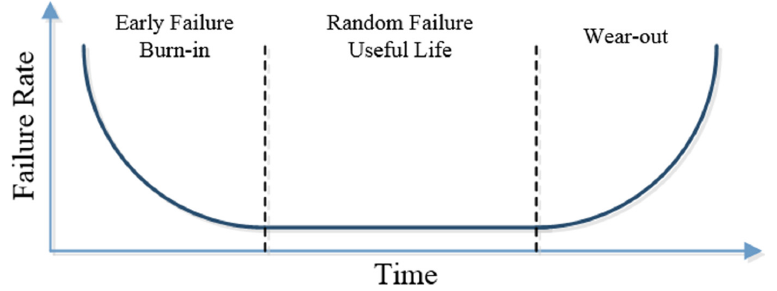
Figure 2. The classical bathtub curve.